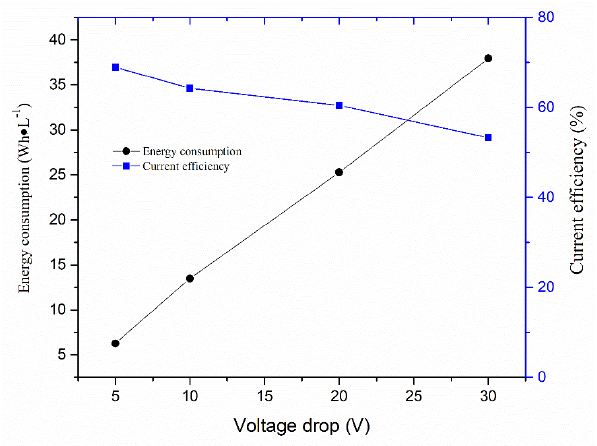
Figure 4. Energy consumption and current efficiency under different voltage.